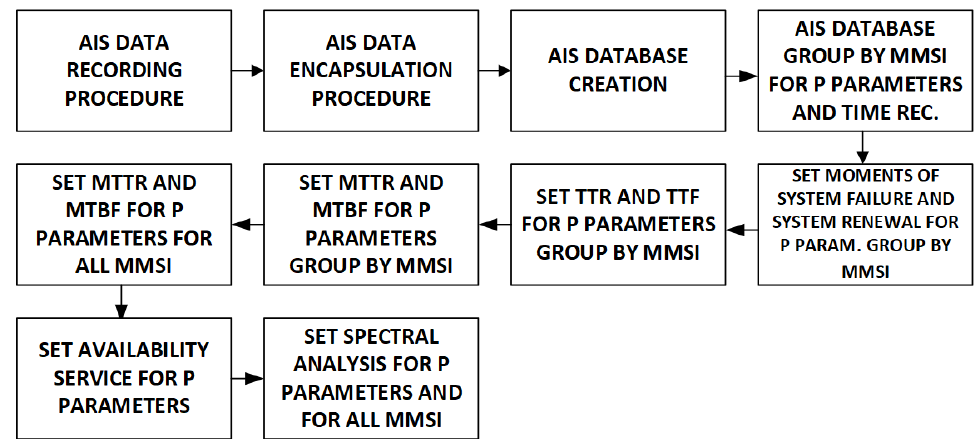
Figure 6. AIS data processing to determine AIS service availability [prepared by the author].